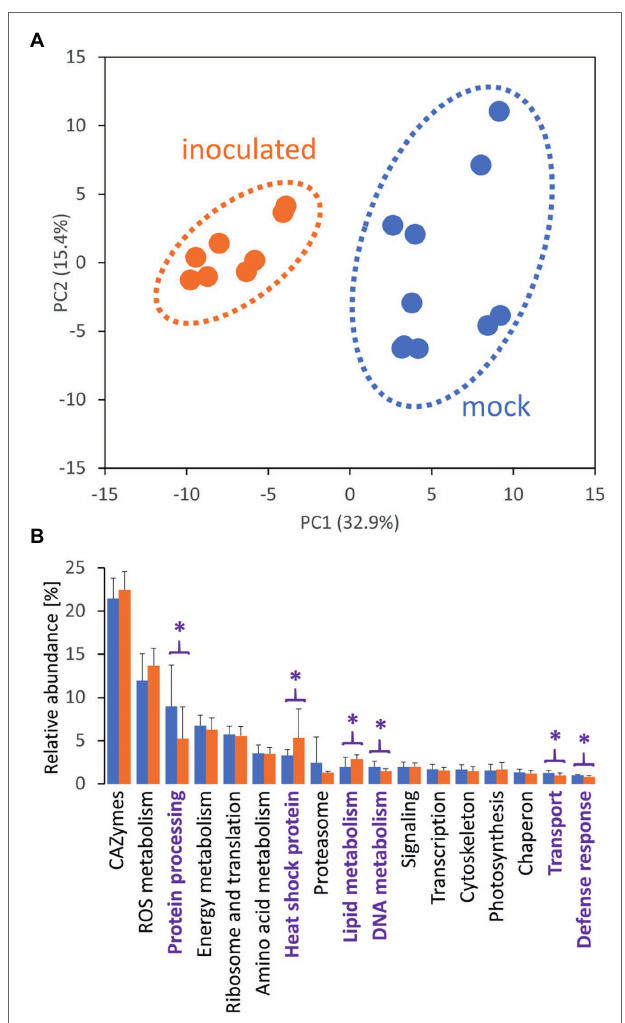
FIGURE 2 | Tulasnella calospora inoculation modulates the composition of the tuber proteome. (A) Differences in proteome composition visualized by Principal Component Analysis. (B) Expected function and estimated relative abundances of tuber proteins. Only categories representing at least 1% of the estimated protein abundances are shown. Statistically significant differences (Student’s t -test; p < 0.05) between inoculated (orange) and mock-treated tubers (blue) are indicated (purple). Results of at least four biological replicates (tubers of four inoculated plants and five mock-treated controls) analyzed in two technical replicates. For details, see Supplementary Table S2